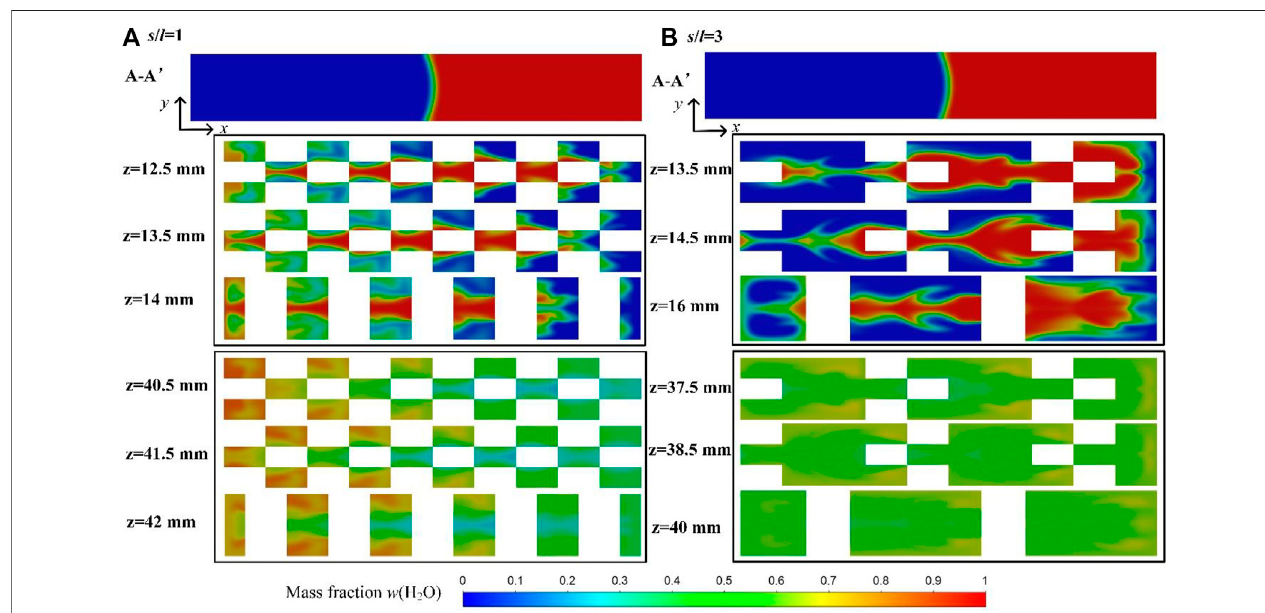
FIGURE 13 | Concentration distribution of water on x-y planes with different ratios of s / l at R e (cid:1) 20 ( V / H (cid:1) 10:10, V (cid:1) 10 mm L (cid:1) 1 mm): (A) s / l (cid:1) 1 and (B) s / l (cid:1) 3.